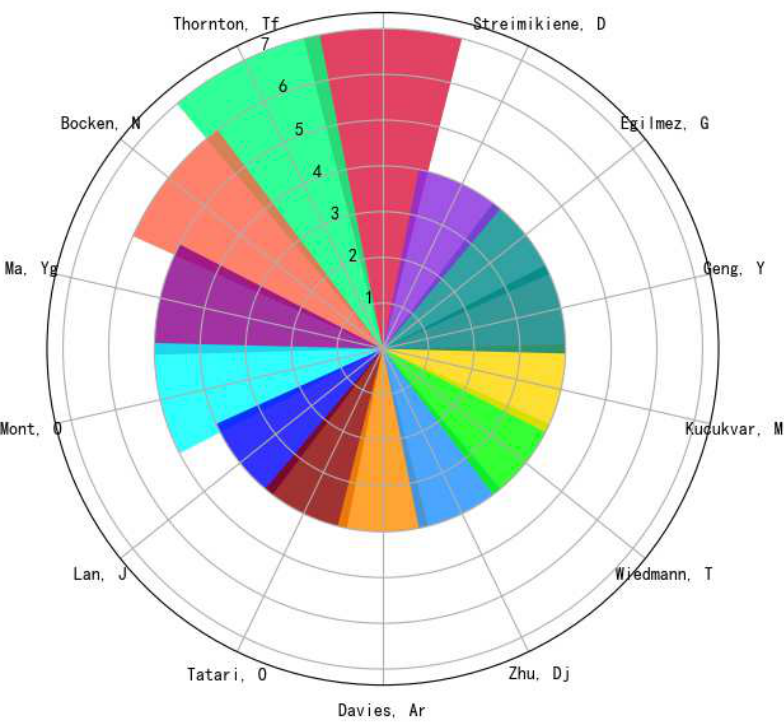
Figure 2. Wind rose diagram of the top 14 most productive authors on sustainable development